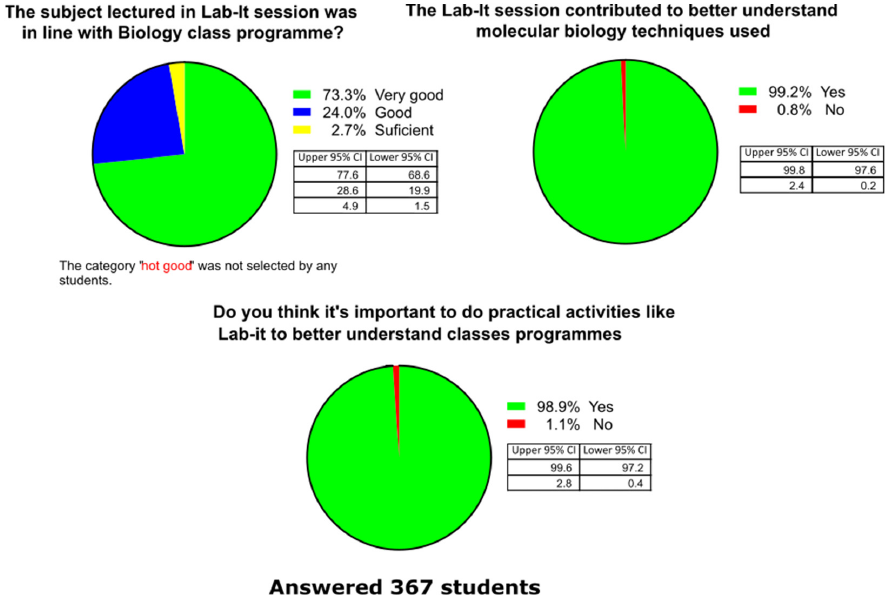
Figure 3. Students’ opinions about the correlation between the practical application of molecular biology methods and theoretical subject approaches in biology classes.